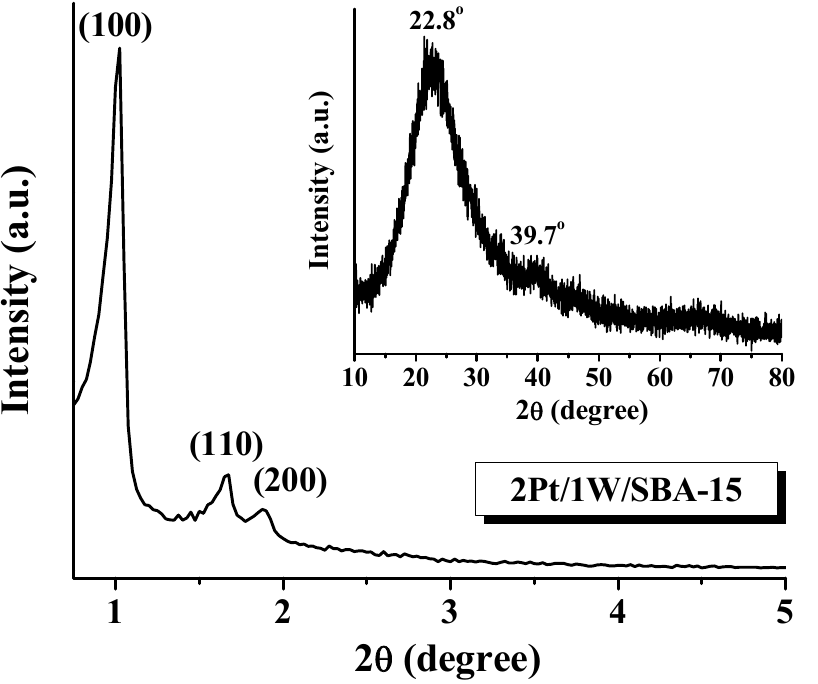
Figure 1. XRD profiles of 2Pt/1W/SBA-15 in low-angle (main panel) and high-angle (inset) regions.